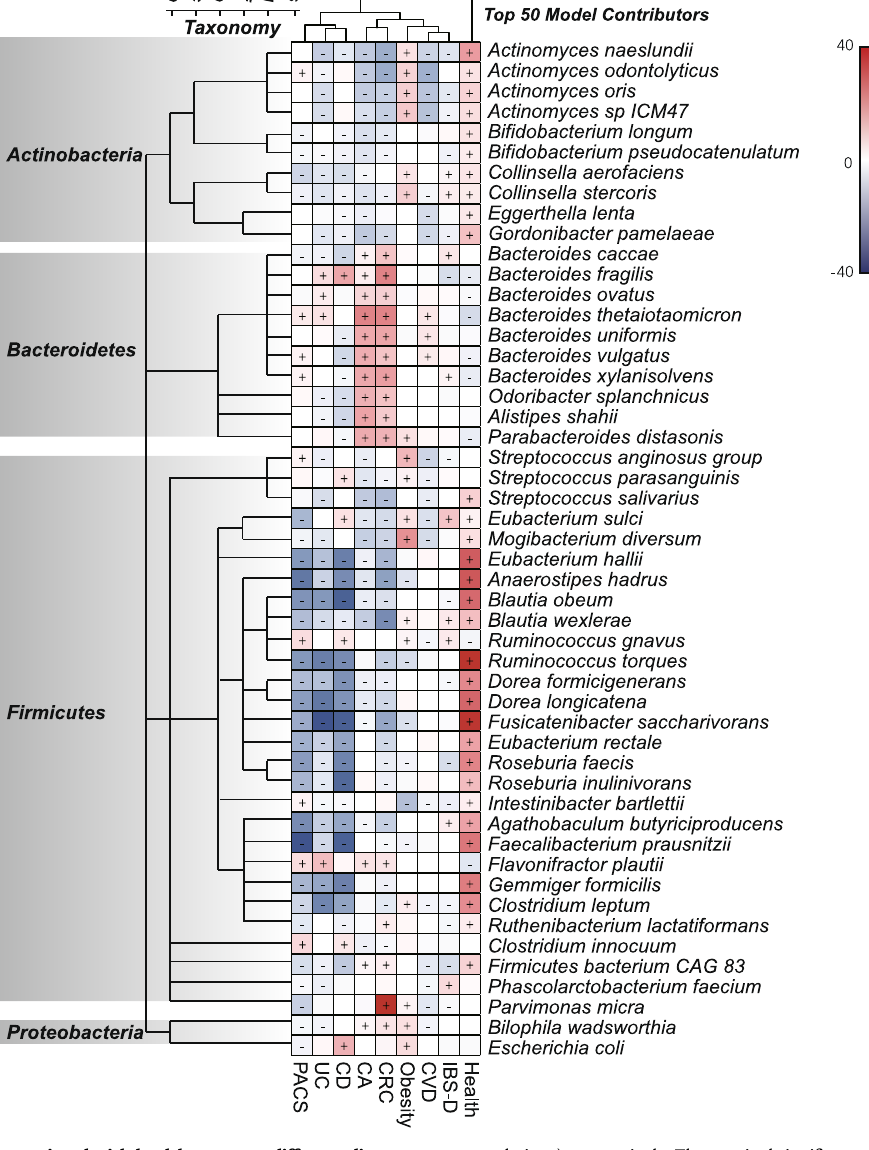
correlations), respectively. The nominal signi fi cance ( p -value) of associations was calculated by MaAsLin 2, and the false discovery rate (FDR) was computed by Benjamini – Hochberg correction. CA colorectal adenomas, CD Crohn ’ s disease, CRC colorectal cancer, CVD cardiovascular disease, IBS-D diarrhoea-dominant irritable bowel syndrome, PACS post-acute COVID-19 syndrome, UC ulcerative colitis. Source data are provided as a Source Data fi